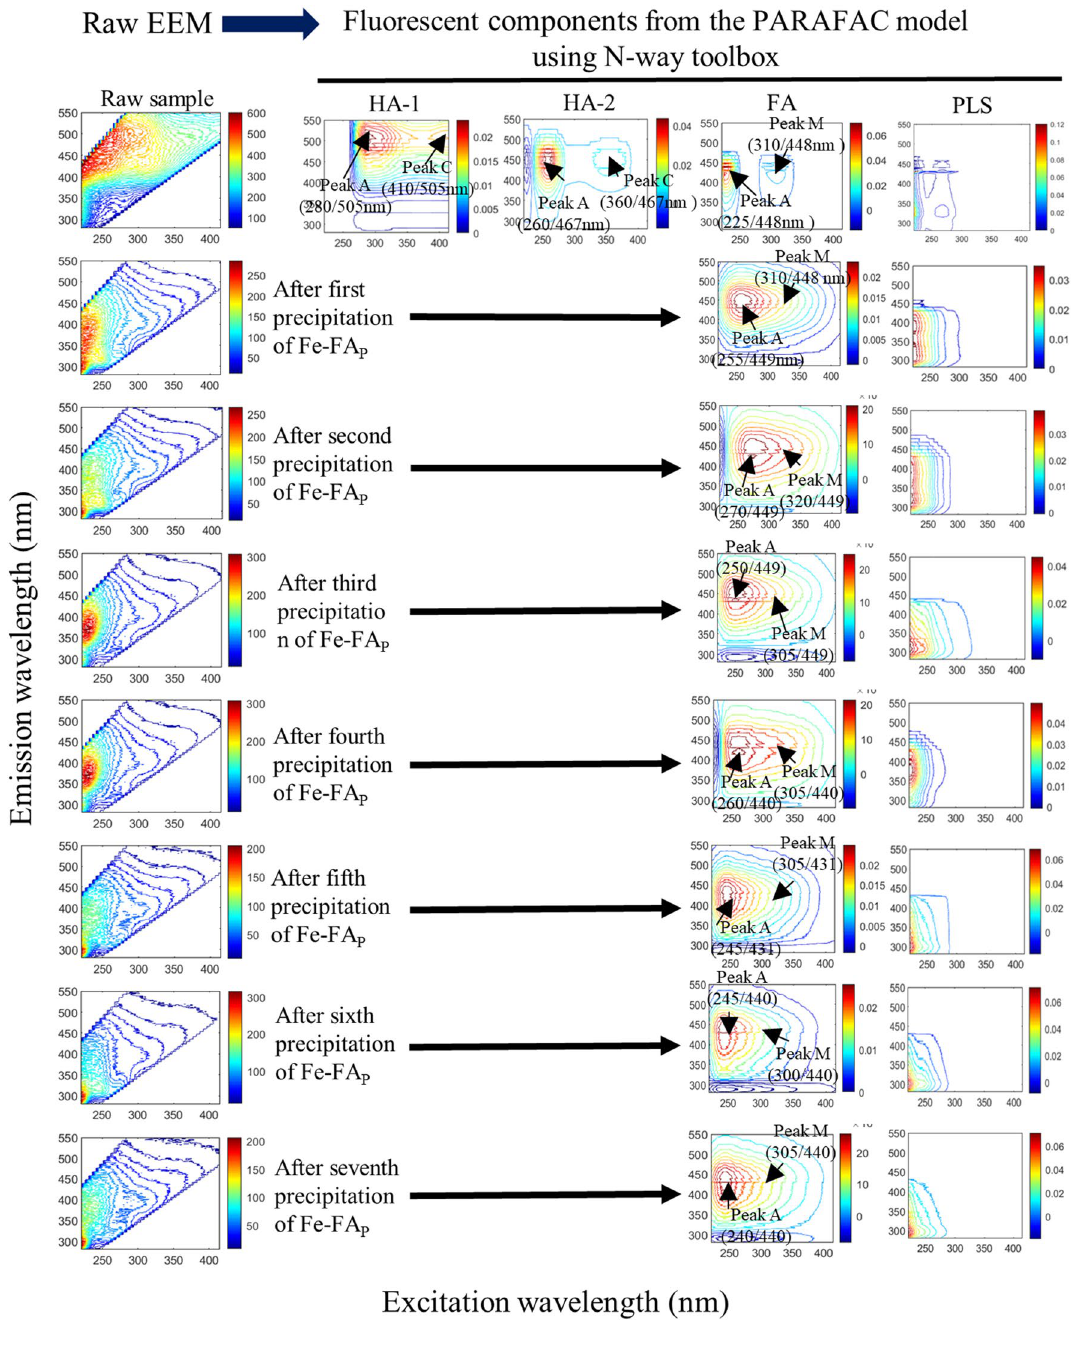
Figure 2. Original EEM spectra (left) and fluorescent components identified by the EEM-PARAFAC model (right) in humic acids (HA) and their remaining solutions (RS) after each repeated precipitation of Fe-HA P . The first line shows the original EEM spectra of the raw sample and the four fluorescent components identified by EEM-PARAFAC, which are, respectively, two humic acids (HA-1 and HA-2), fulvic acids (FA) and protein-like substances (PLS). Each subsequent row shows the original EEM spectra of the remaining solution (RS) after each of seven precipitation of Fe-FA P and the fluorescent components identified by